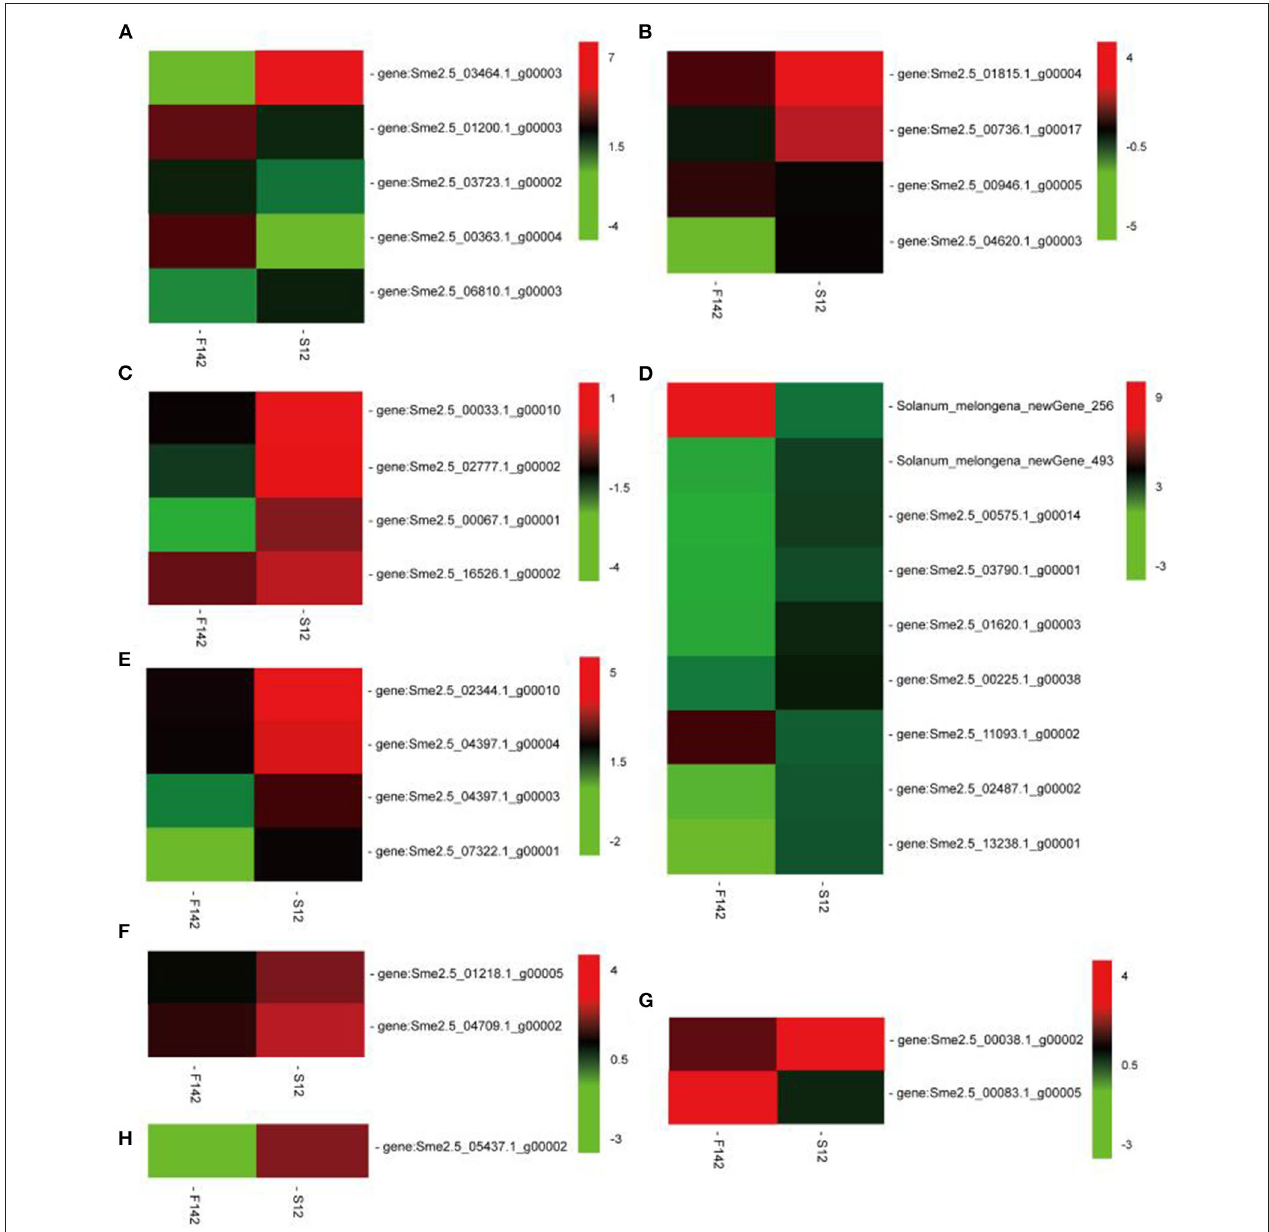
FIGURE 4 | Expression changes in the genes involved in the (A) jasmonic acid, (B) ethylene, (C) auxin, (D) other hormones, (E) crassinolide, (F) cytokinin, (G) gibberellin, and (H) abscisic acid signaling pathways in F142 and S12.